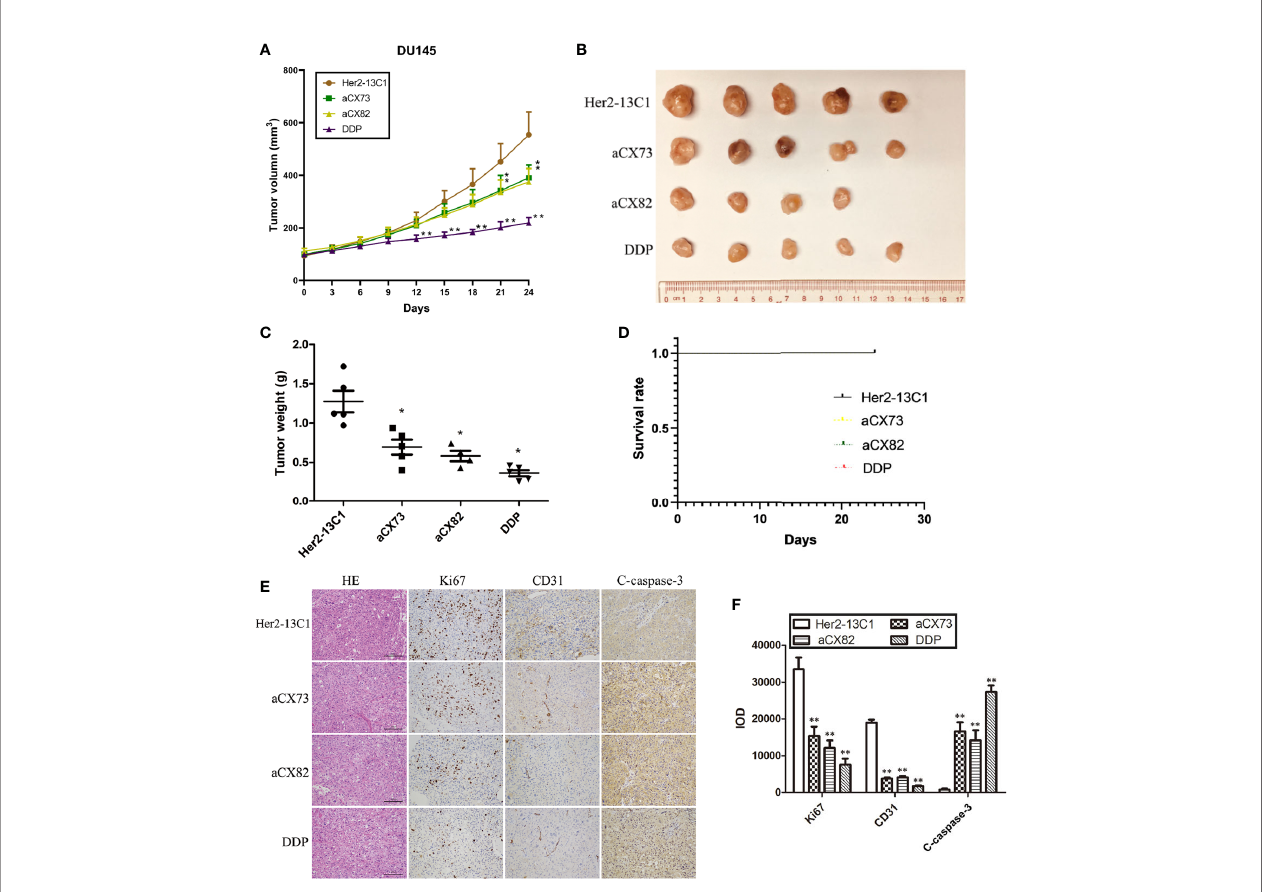
FIGURE 10 | Anti-CXCR4 scFvs can decrease DU145 xenograft growth. (A) Mice were inoculated with DU145 cells subcutaneously. Following tumors formation, mice were inoculated intravenously with the anti-CXCR4 scFvs (aCX73 and aCX82), the negative control antibody Her2-13C1 and DDP. (B, C) After euthanization of the mice on day 24 after the fi rst inoculation, the tumors were excised. (D) The survival rates of mice treated with aCX73, aCX82, and DDP were determined compared to the negative control antibody Her2-13C1 using a log-rank (Mantel-Cox) test. Only the black line for the fi rst group (Her2-13C1) was seen, and the other color lines for the other groups were invisible because all the color lines for all the groups were in the exact same position. (E) Tumor sections were incubated with HE or antibodies against Ki67, CD31 and c-caspase-3. (F) IOD was determined from Figure 10E . Results represent mean ± S.D. * P < 0.05 and ** P < 0.01. TABLE 1 | The risk of developing tumors in mice (hazard ratio) treated with the scFvs and DDP compared to the negative control antibody Her2-13C1 using a log-rank (Mantel-Cox) test.